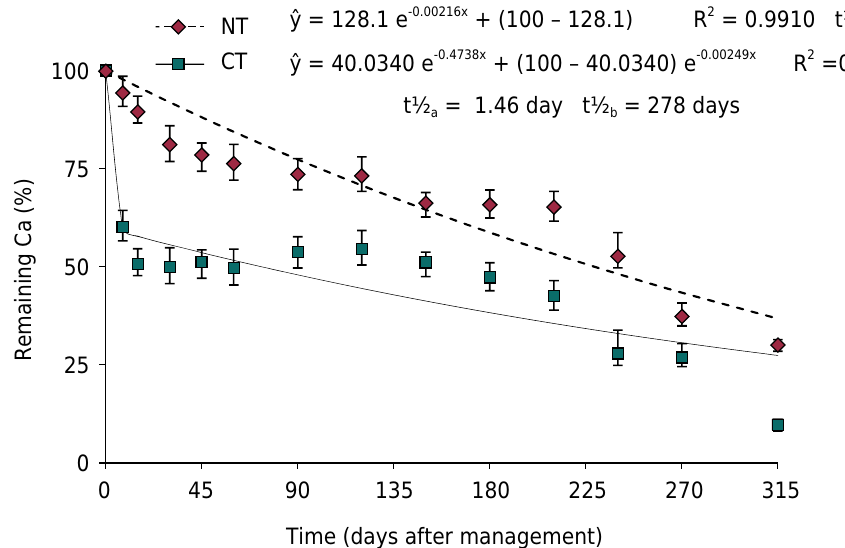
Figure 5. Means of remaining calcium of aboveground phytomass after management of three mixtures of cover crops in mango interrows in Petrolina, Pernambuco, Brazil (PM1 = 75 % leguminous species + 25 % grass and oilseed species; PM2 = 25 % leguminous species + 75 % grass and oilseed species; and SV = spontaneous vegetation) under two soil tillage systems (NT = no tillage; CT = conventional tillage); t ½ = half-life time; t½ a = half-life time of more easily decomposable compartment; t ½ b = half-life time of recalcitrant compartment. Bars represent the standard error of the